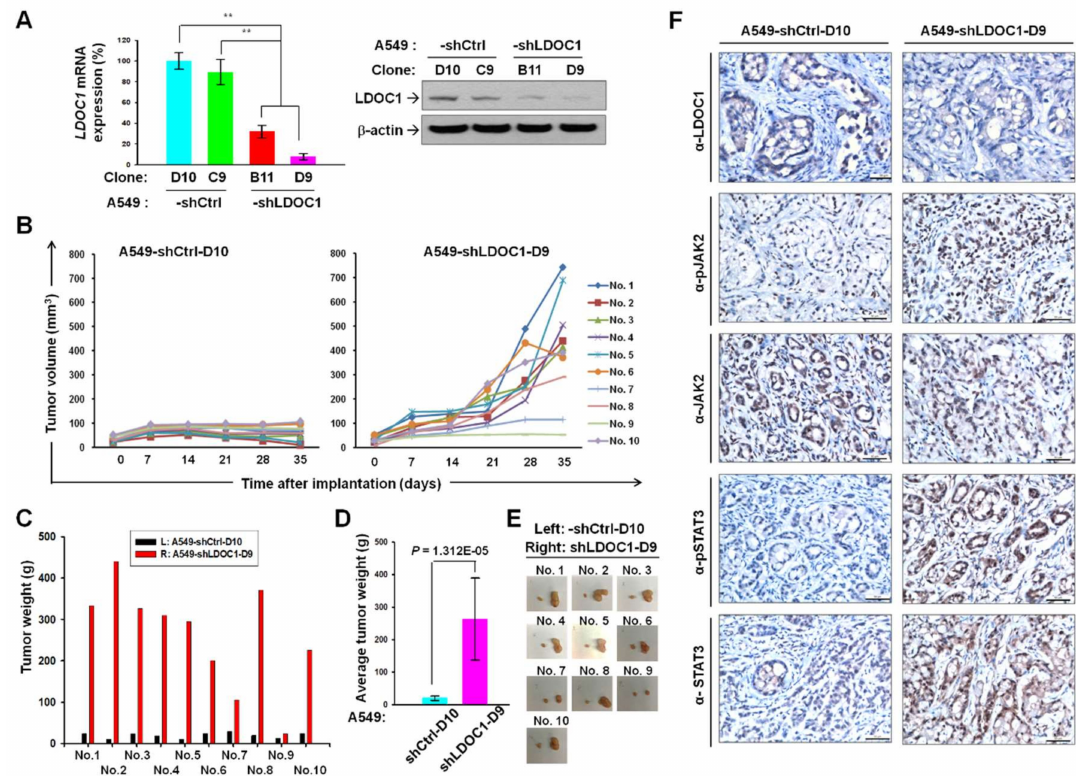
Figure 5. Reduction in LDOC1 expression promoted tumor growth in subcutaneous xenograft models of lung cancer. ( A ) Expression of LDOC1 mRNA (left) and protein (right) in A549-derived clones stably suppressed either LDOC1 expression (A549-shLDOC1-B11 and -D9) or knockdown controls (A549-shCtrl-D10 and-C9). ** p < 0.01. ( B – E . A tumor xenograft experiment was performed by subcutaneously injecting A549-shLDOC1-D9 and A549-shCtrl-D10 cells into the right and left back of Balb/c nu/nu mice, respectively. ( B ) The volumes of xenograft tumors in the mice were measured as described in Materials and Methods. The individual ( C ) and the average ( D ) tumor weight (data indicated mean tumor weight ± SD, n = 10) and the images ( E ) of harvested tumors derived from A549-shLDOC1-D9 and A549-shCtrl-D10 cells on each mouse were compared on day 35. ( F ) Representative immunostaining of LDOC1, pJAK2, JAK2, pSTAT3 Y705 , and STAT3 in xenograft tumors derived from A549-shLDOC1-D9 and A549-shCtrl-D10 cells. Scale Bar, 50 µ